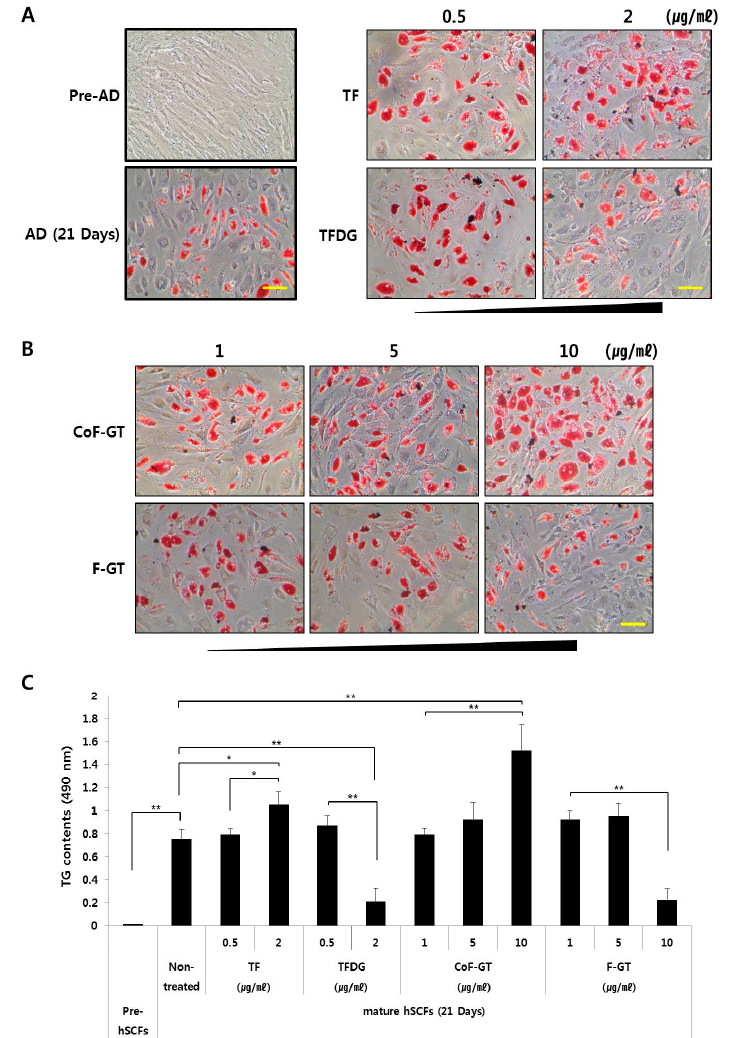
Figure 3. Effect of TF on hSCF differentiation. Pre- and mature adipocyte states of hSCFs fixed and stained with Oil Red O (ORO) at indicated time points and examined by light microscopy. ( A ) Left , untreated group; right , TF- and TFDG-treated groups used as a positive control; ( B ) CoF- and F-GT treated groups. Scale bar, 200 μ m; ( C ) TG content was determined by measuring the absorbance at 490 nm. Data are presented as mean ± SD. * p < 0.05, ** p < 0.01.